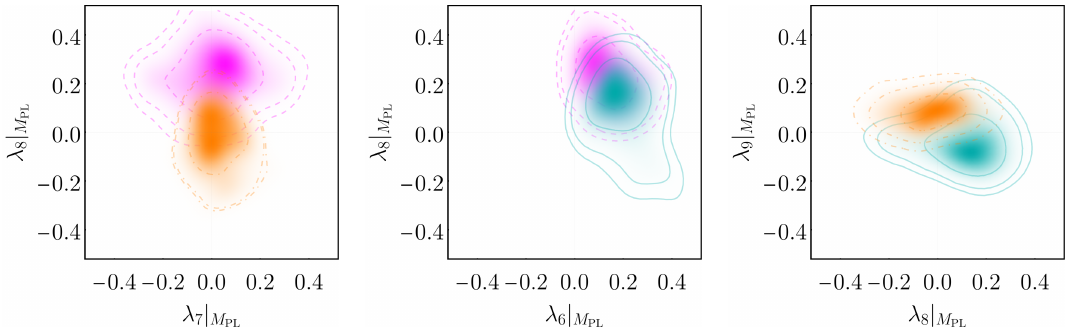
Figure 5 . Probability-density functions (PDFs) of pairs of different admissible breakings ( SU(5) in cyan; SU(5) × U(1) in dashed and magenta; SU(3) × SU(2) × U(1) in dot-dashed and orange) for selected projections into 2-dimensional slices of theory space. Contour lines indicate the 1 σ -, 2 σ -, and 3 σ -regions obtained with a Gaußian kernel of width 0 . 05 . We only show those projections which best discriminate the two respective breaking